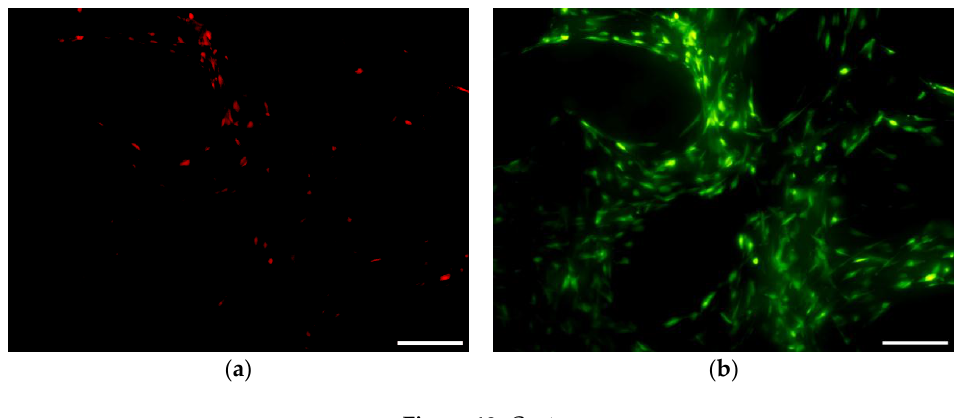
Figure 18. Cont. Figure 18. Cont.